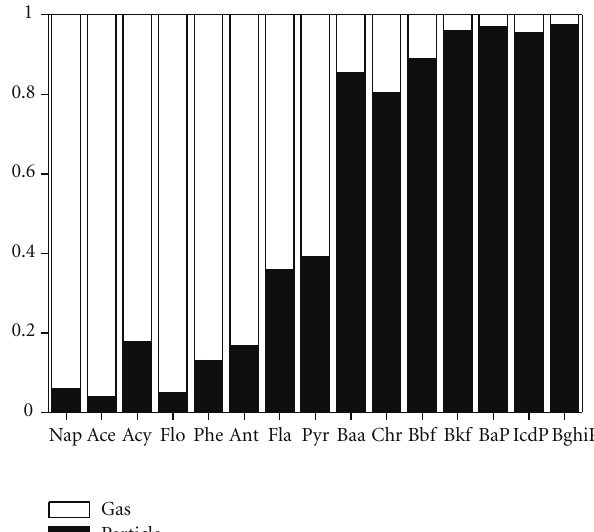
Figure 5: Ratio of particulate and gaseous PAHs (P/G) at Lake Small